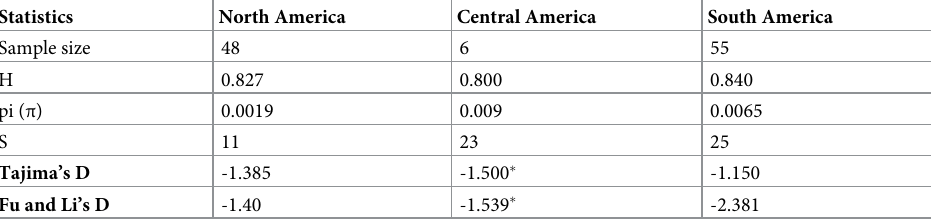
Table 2. Genetic diversity and neutrality tests for mtTcIII lineage by